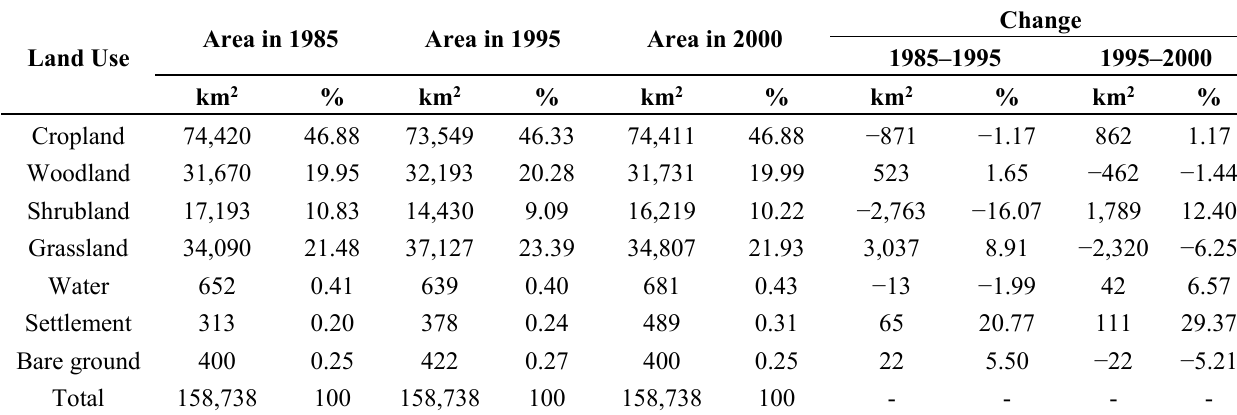
Table 3. Final land use change in the Jialing River